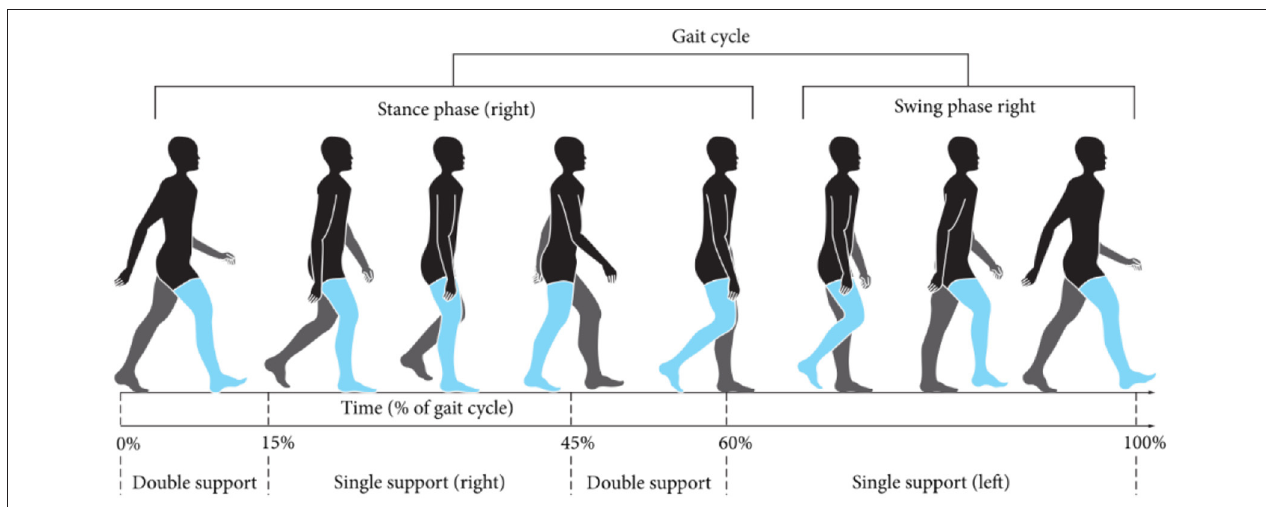
FIGURE 2 | Human gait cycle (Cheze et al.,